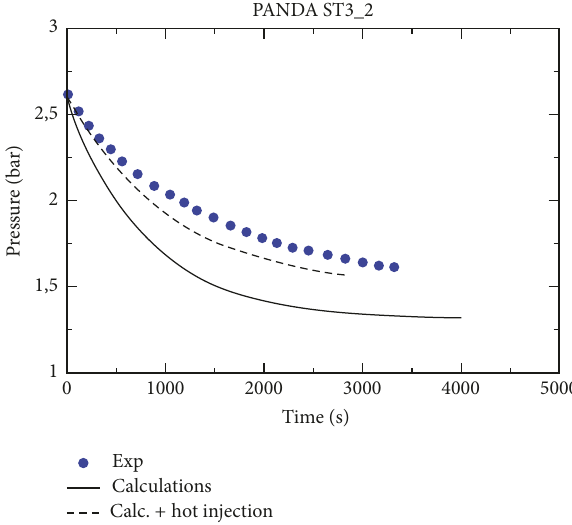
Figure 27: Time-dependent pressure in Vessel-1, sensitivity to the droplet diameter at injection.